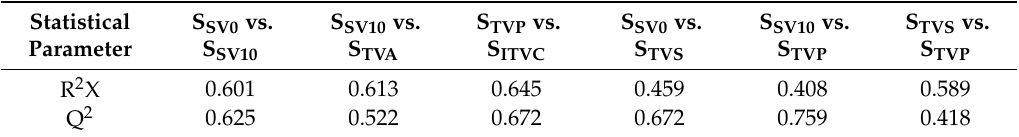
Table 3. Statistical parameters of OPLS-DA analysis for di ff erent